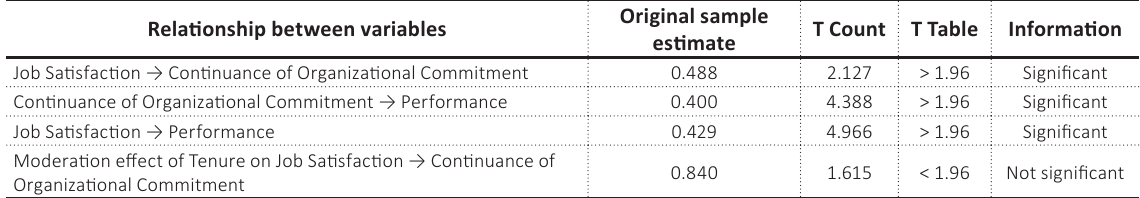
Table 5. Estimated coefficient values between the